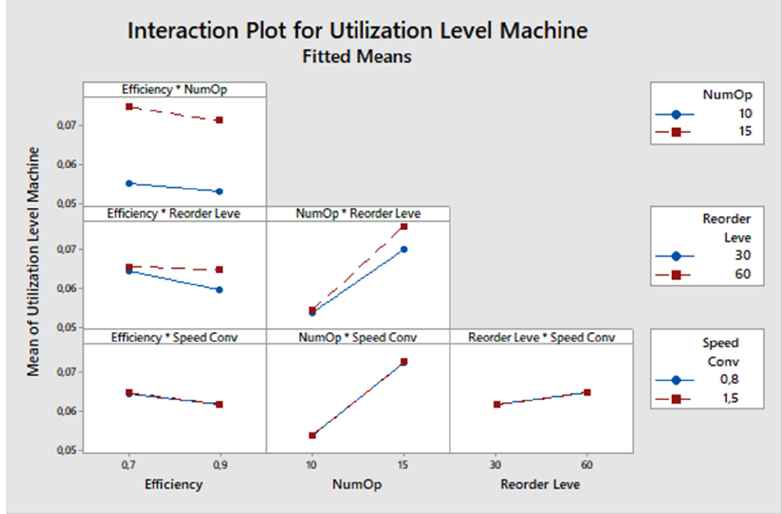
Figure 14. Main Effects Plot for Utilization Level Machine.